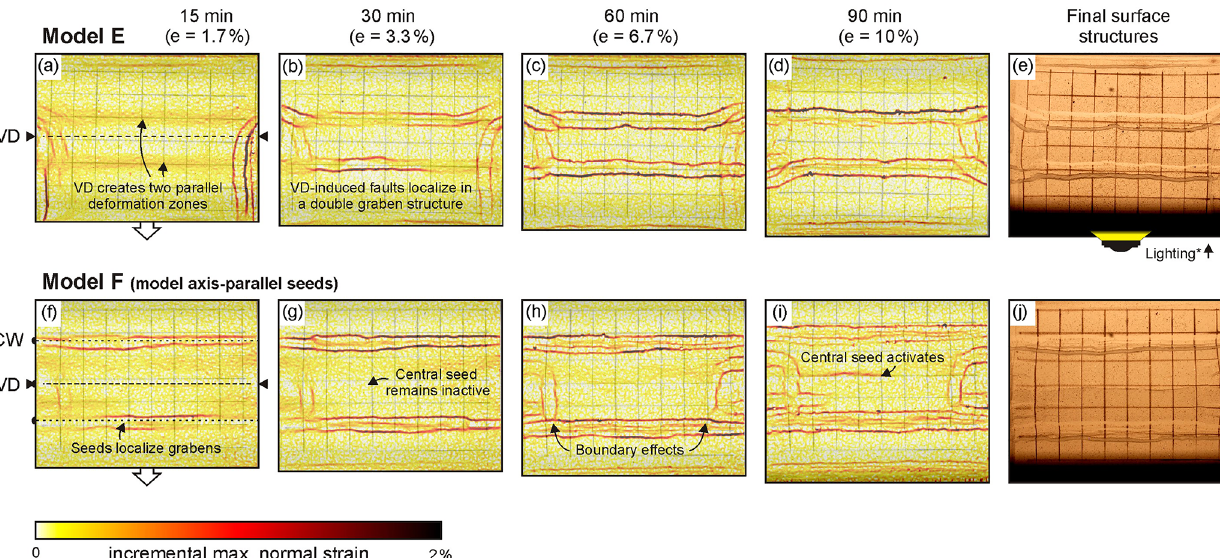
Figure 4. Incremental maximum normal strain maps of Sub-series 1.2 models (with model axis-parallel VD, and equally oriented seeds, if applied) obtained through PIV analysis, taken as a proxy of fault activity. Note that these models have a thicker (1.5cm) viscous layer and a thinner (2.5cm) brittle cover than the other models in this paper (standard layering being 3 cm of brittle material on top of 1cm of viscous material). The increments for PIV analysis were 1min, i.e. every 0.33mm of extension. The original model map-view pictures are visible in the background. Note that Model F includes a crustal weakness (seed) above and parallel to the VD. The right-hand column depicts the model surface at the end of each experiment. VD: velocity discontinuity. CW: (simulated) crustal weakness. ∗ Shadows cast by one-sided lighting allowing a better visualization of the final surface structures